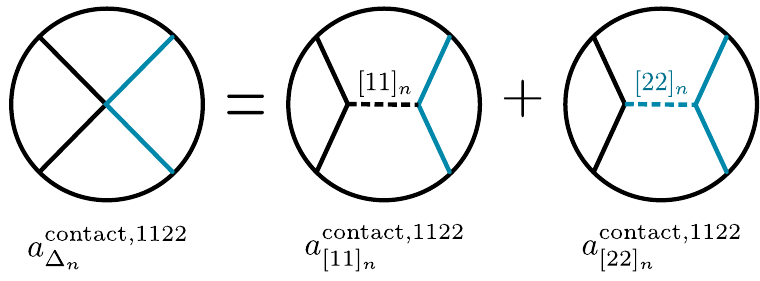
Figure 5 . Pictorial representation of equation (5.8) showing the OPE coefficients of the double trace operators [11] and [22] appearing in the s -channel conformal block decomposition of the n n contact diagram written in